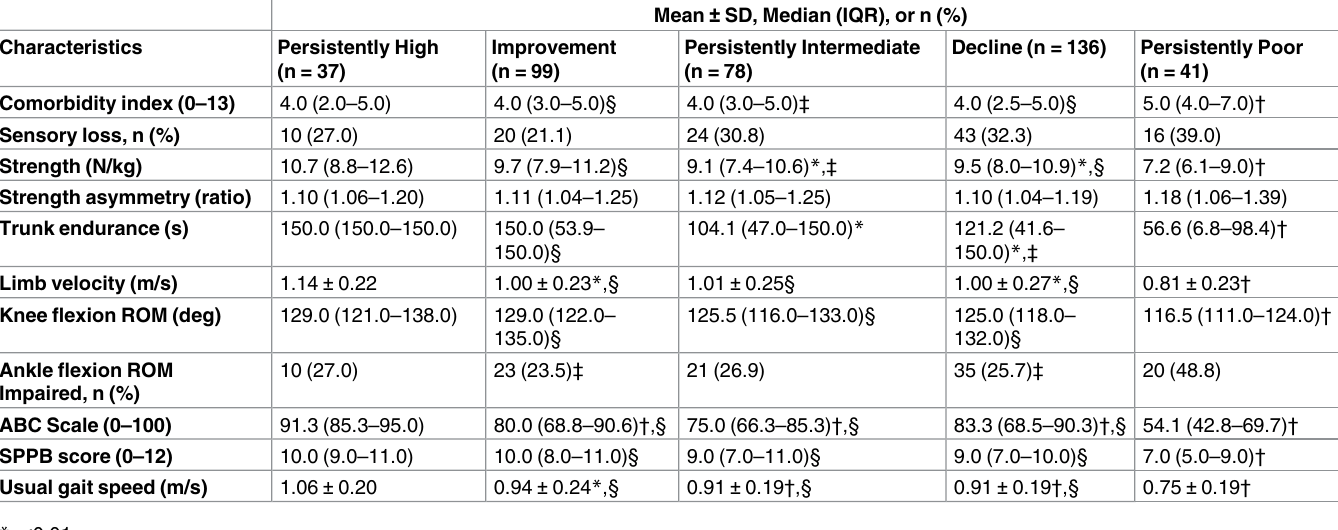
Table 4. Baseline health and function by BLE mobility trajectoryover 2 year follow-up (N = 391).